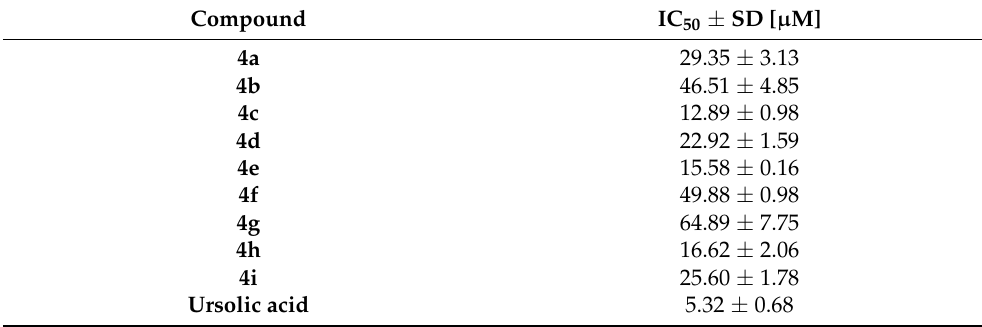
Table 1. Elastase inhibitory activity of phthalimide ‐ thiazoles 4a – 4i compared to standard inhibi ‐ tor.